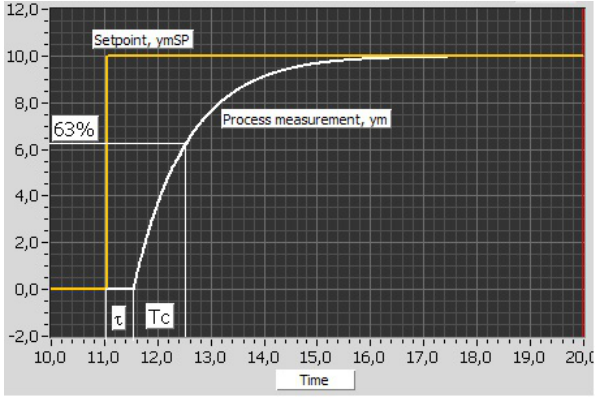
Figure 3: Step response of the specified tracking trans- fer function Eq. (3) in Skogestad’s PID tun- ing method.